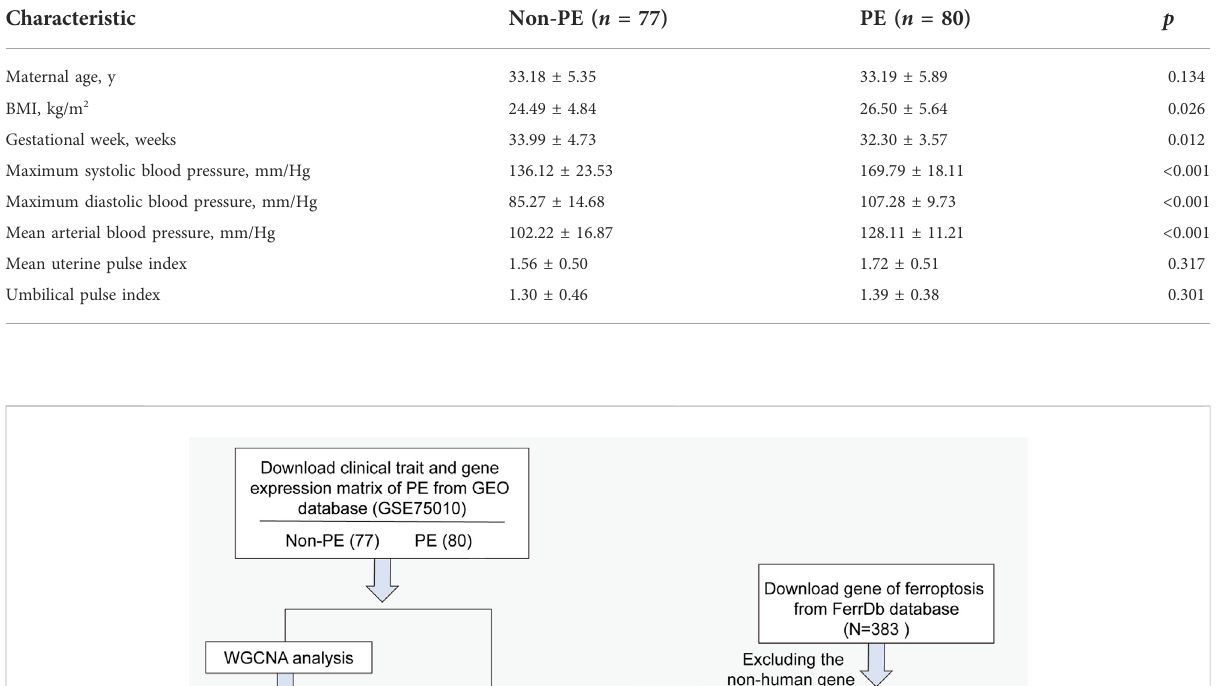
TABLE 1 Clinical information and sample size for the GSE75010 dataset.